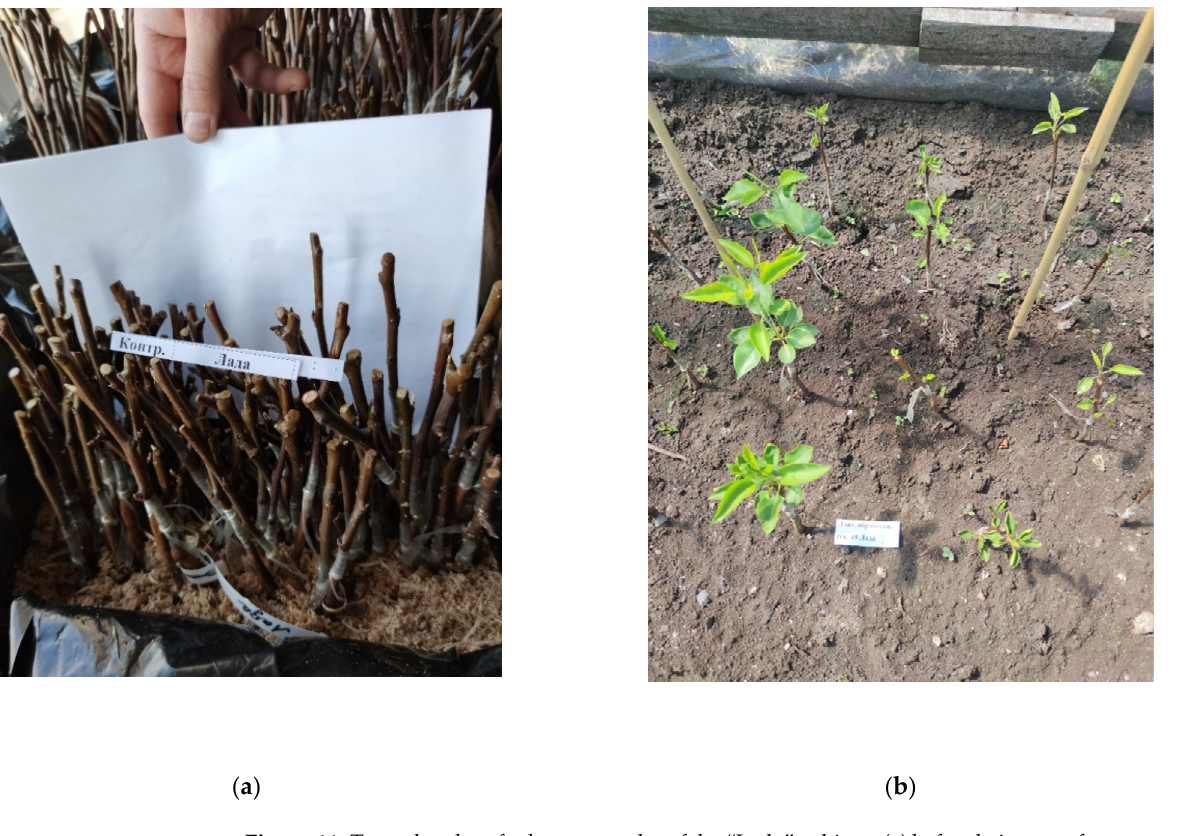
Figure 11. Treated and grafted pear samples of the “Lada” cultivar: ( a ) before being sent for preservation (2 months) in a refrigerator (3 ± 1) °C; ( b ) 1 month after planting in a greenhouse (35 ± 1) °C.